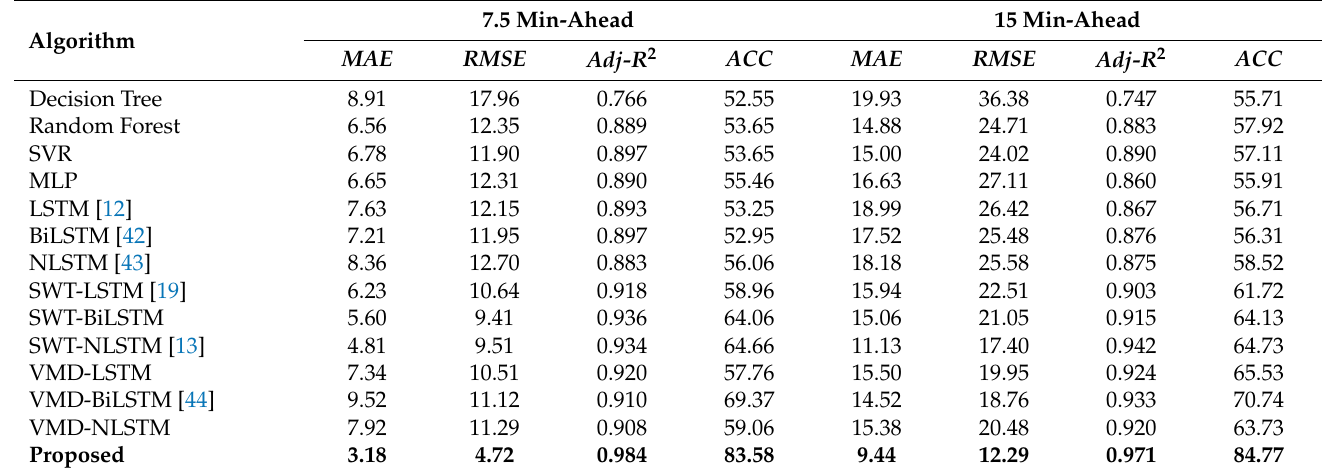
Table 5. Performance comparison of different prediction methods based on dataset 1.